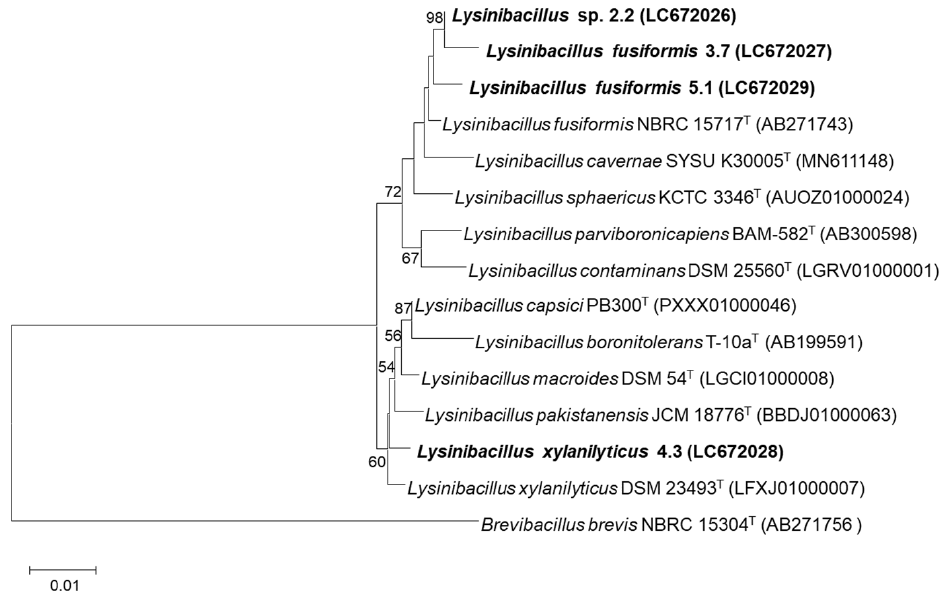
Figure 1. Phylogenetic placement of the isolated ureolytic bacteria and their closely related taxa based on sequence analysis of the 16S rRNA gene using the Neighbor-Joining method based on the Maximum Composite Likelihood model. Named in bold type are the isolates obtained from this study. Numbers on branches indicate percentages of bootstrap sampling (>50%), derived from 1000 samples. Bars, 0.01 substitutions per nucleotide position.